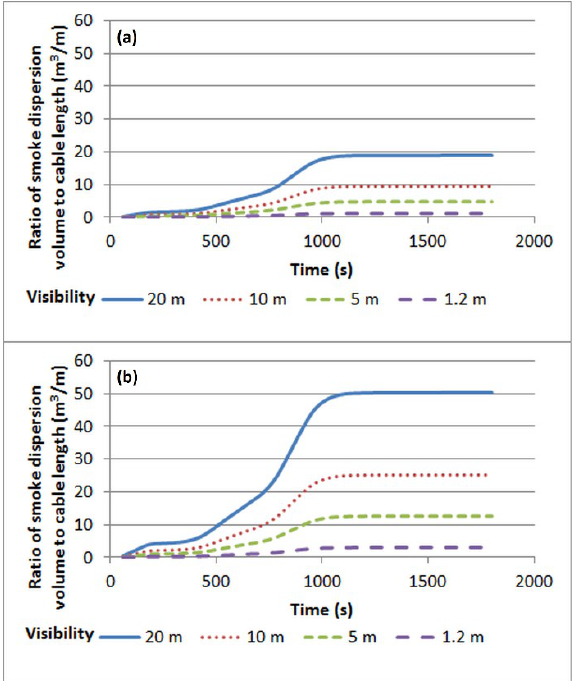
Figure 5. Critical ratios of smoke volume to length of the burning CHKE-R cable, by which the visibility of signs drop to 20, 10, 5 and 1.2 m for: ( a ) light-emitting signs; ( b ) light-reflective signs.